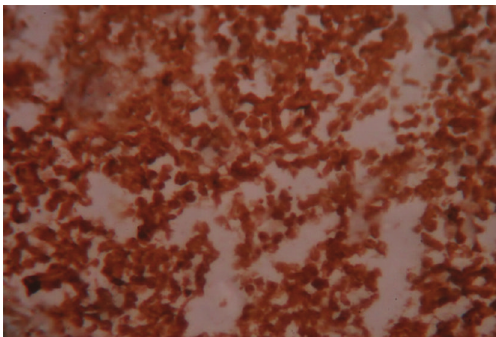
Figure 1: Chest X-ray of Case 1 at the presentation.